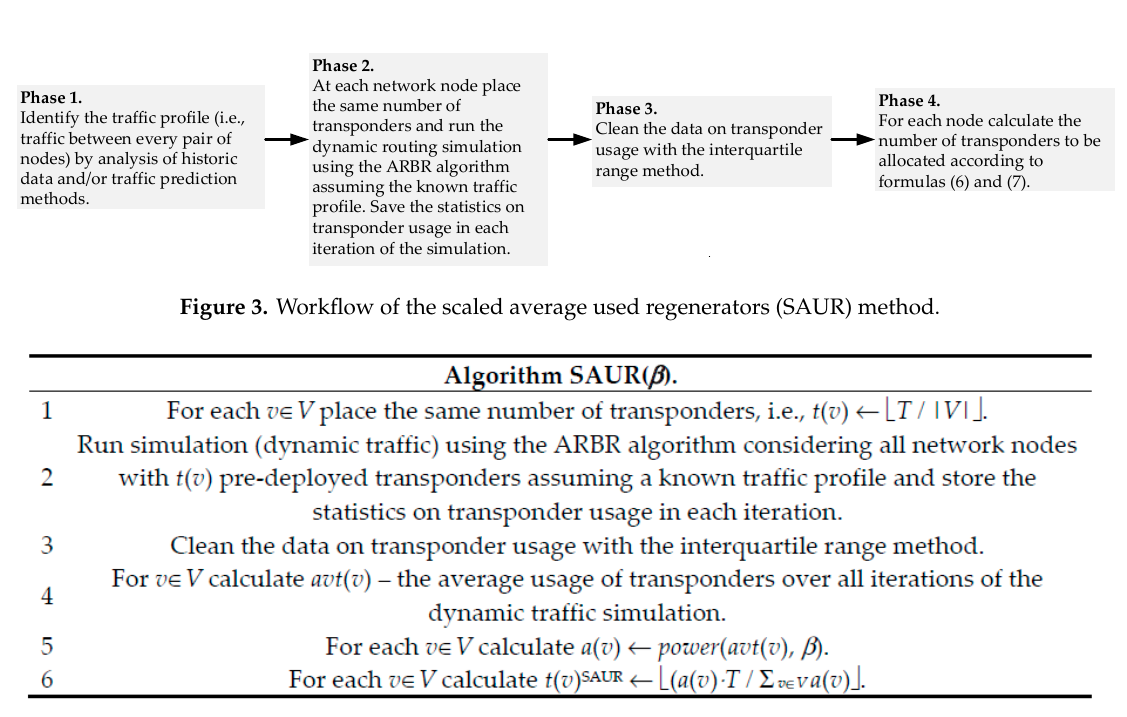
Figure 4. SAUR pseudocode.